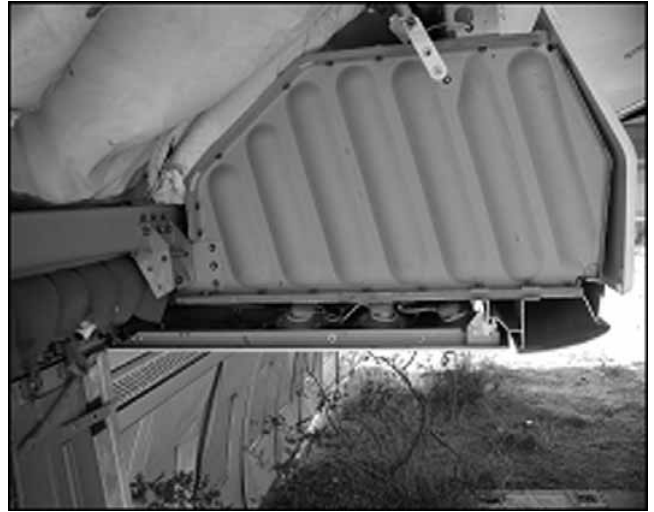
Fig. 7. Bin location and attachment in Boeing 737–100 fuselage